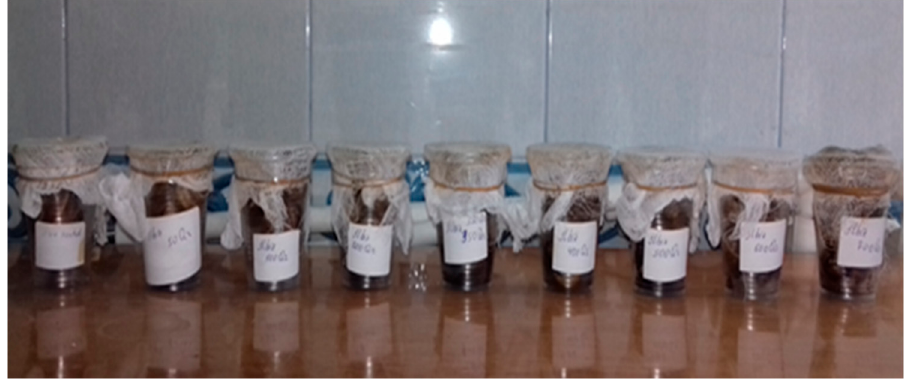
Figure 8. Control and irradiation with different doses of packaged grape snails.